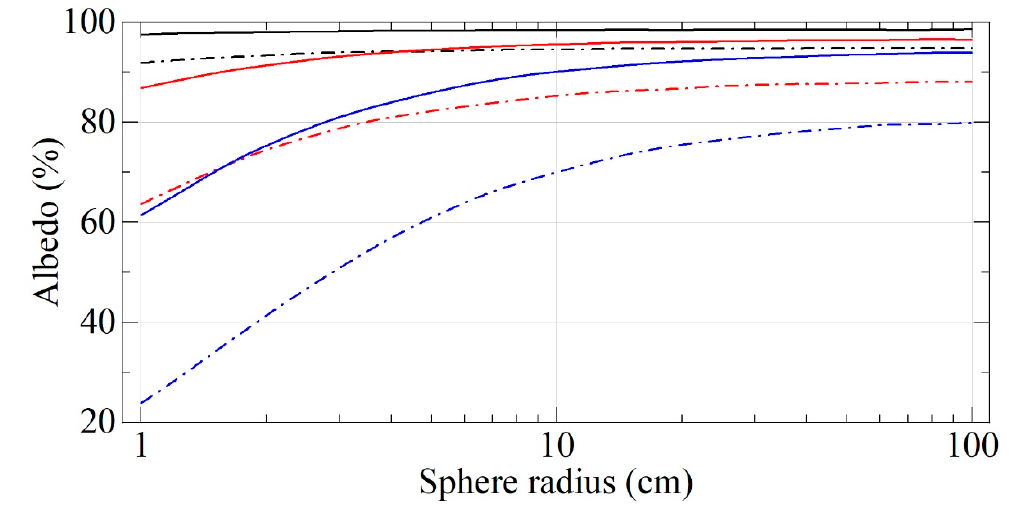
Figure 13. Neutron albedo for the velocities of 50 m/s (black lines), 100 m/s (red lines), and 150 m/s (blue lines) for DF-DNDs (solid lines) and DNDs (dash-dotted lines) versus the cavity radius. The incident neutrons are isotropic; the powder thickness is infinite. DF-DNDs density is equal to 0.56 g/cm 3 . The DNDs density is the same as it is in Figure 12 and equal to 0.19 g/cm 3 .